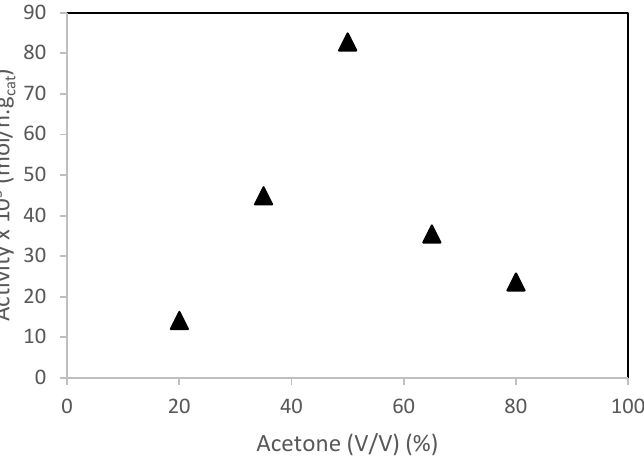
Figure 8. Hydration of camphene over PW4‑SBA‑15‑SO 3 H catalysts. The effect of the solvent. Re‑action conditions: T = 50 °C; m cat = 0.482 g; V = 114 mL of aqueous acetone; n camphene = 7.5 mmol, t = 4 h.